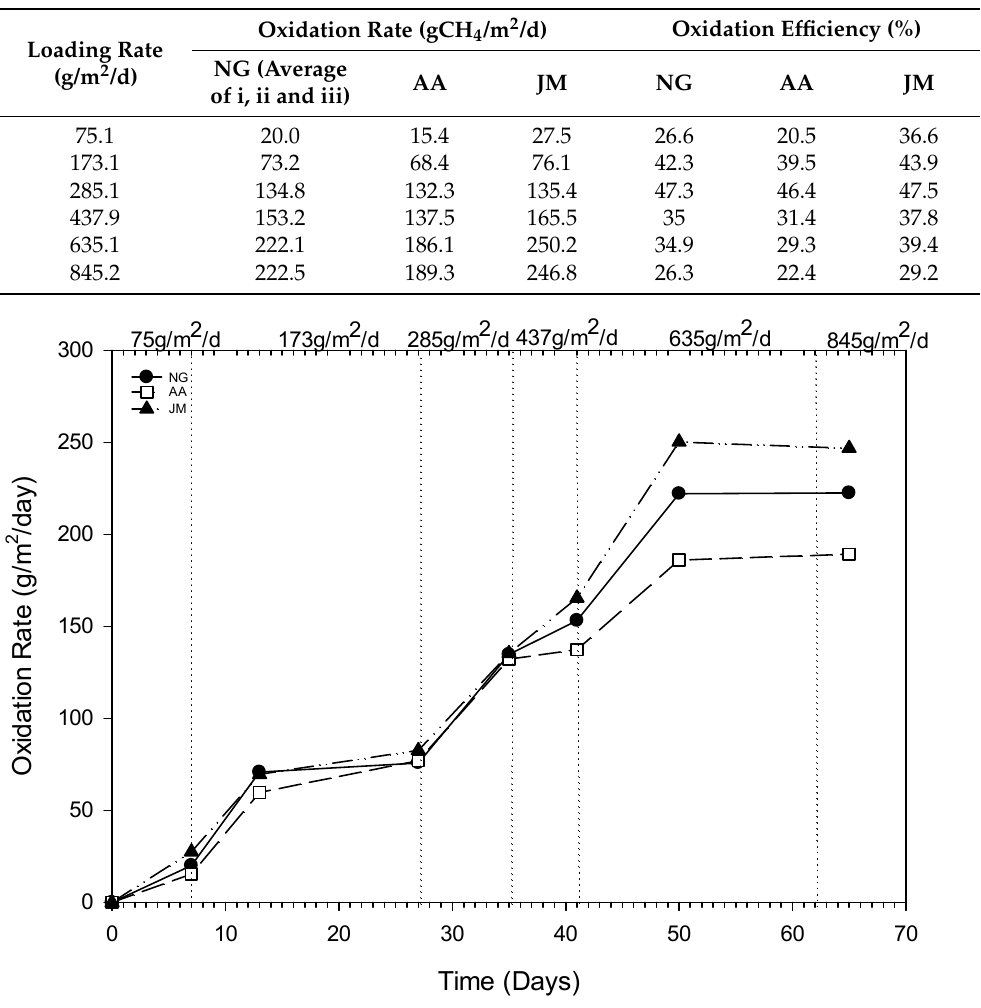
Figure 6. Time-dependent methane oxidation rates (NG: native grass (triplicates indicated as i, ii and iii), AA: alfalfa and JM: Japanese millet). Table 3. Average oxidation rate and oxidation efficiencies of columns.